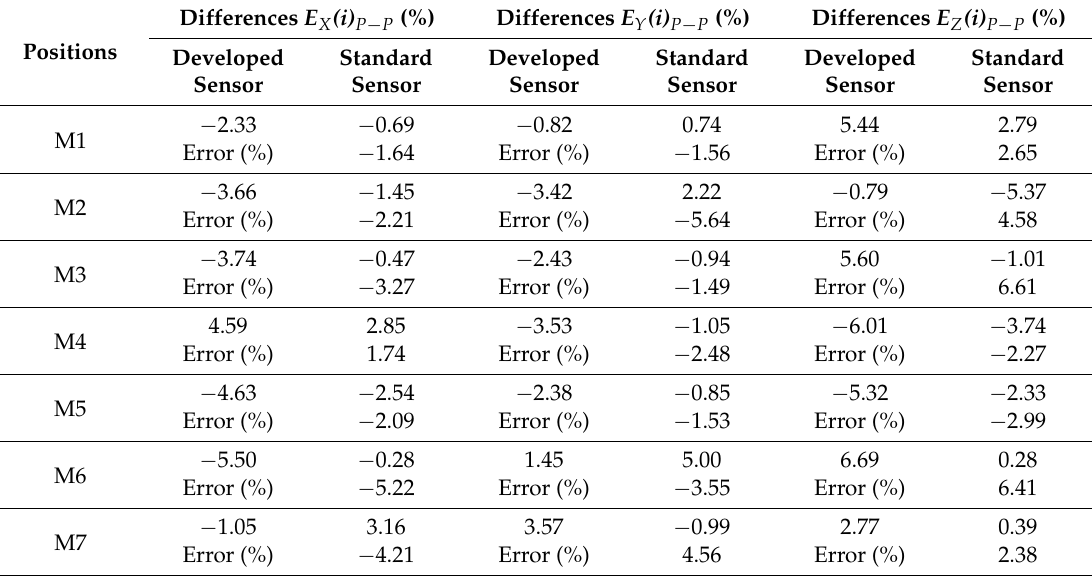
Table 6. The differences of the averaged peak to peak values of milling force in each group.